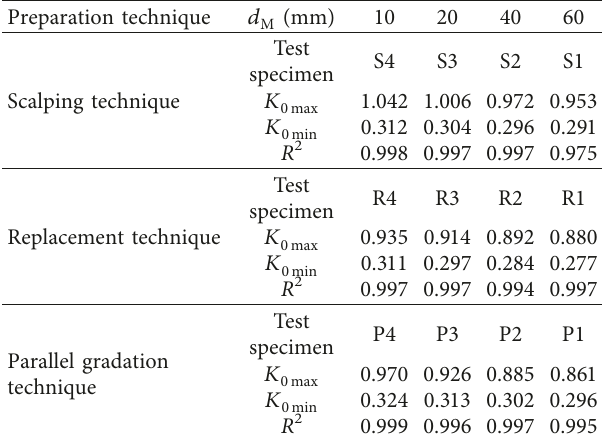
K 0max and 0min of the test